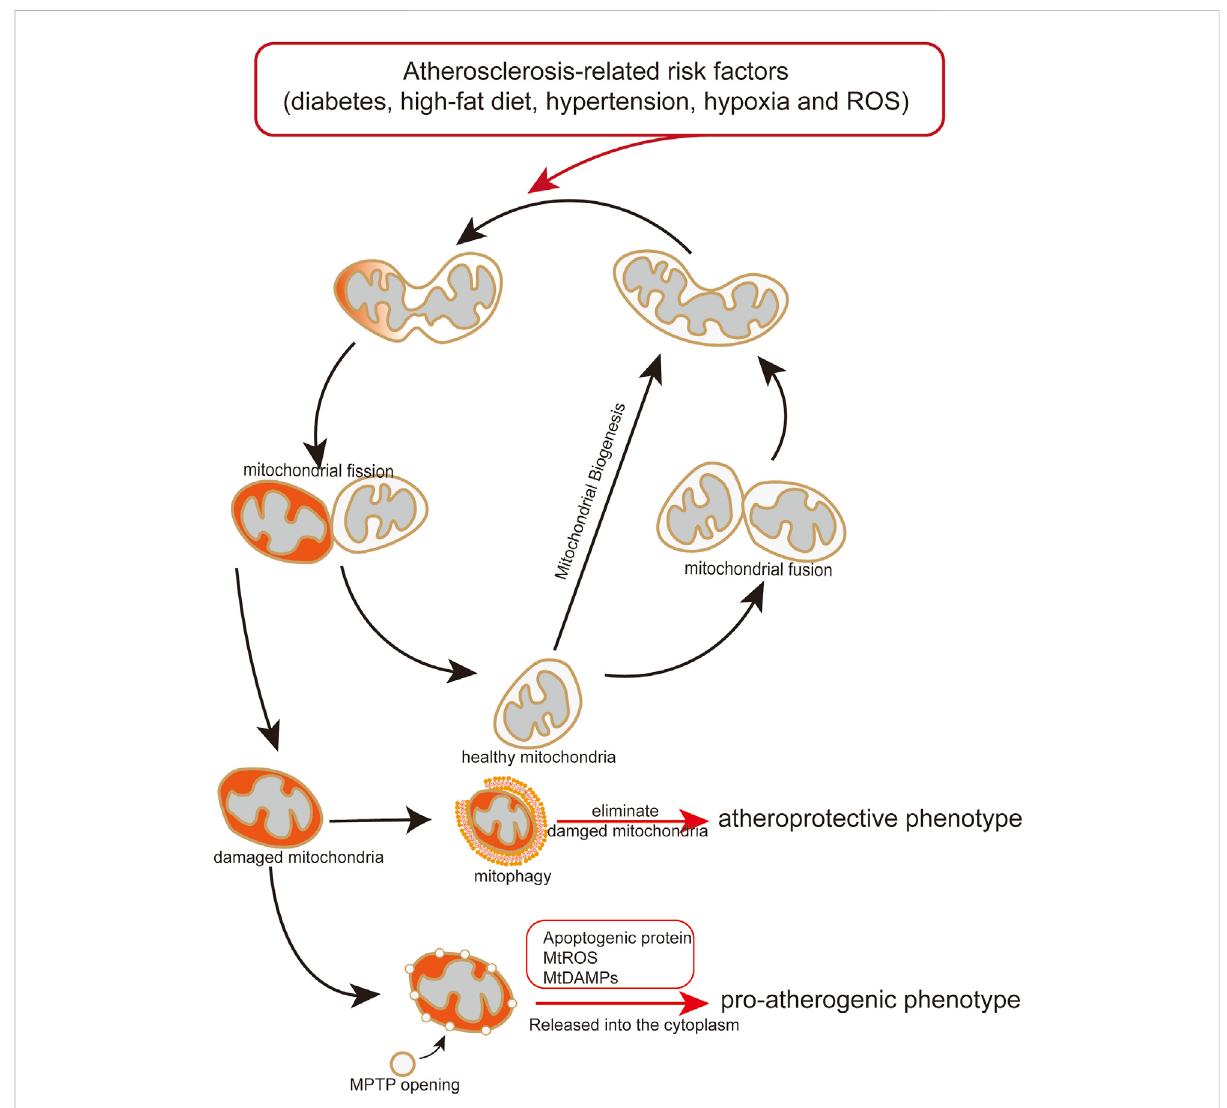
FIGURE 3 Endothelial mitochondria mediate pro-atherogenic or atheroprotective phenotype. Atherosclerosis-related risk factors induce mitochondrial damage and dysfunction. Damaged or dysfunctional mitochondria release mitochondrial mtDAMPs and ROS to the cytoplasm, causing endothelial transformation to a proatherogenic phenotype. Mitophagy maintains endothelial homeostasis by eliminating damaged or dysfunctional mitochondria, play an atheroprotective